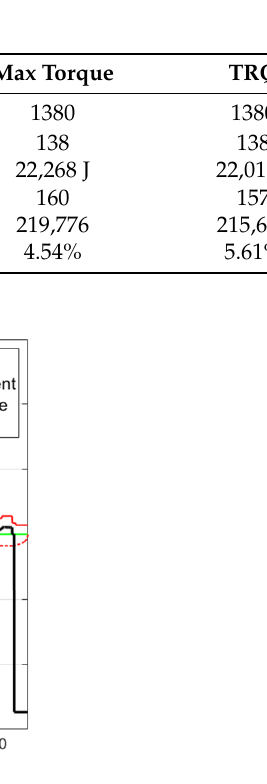
Figure 12. The resulting force components of the driving strategy on the London Track by TRQ optimization.